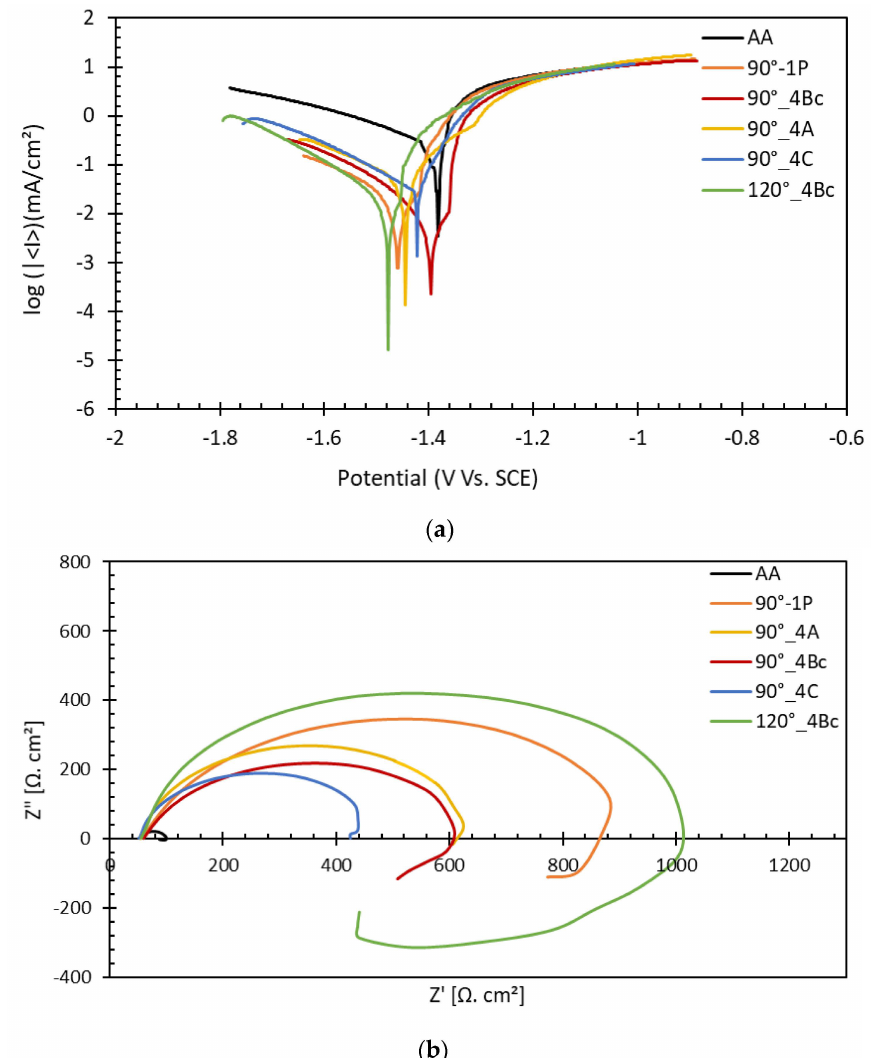
Figure 5. Corrosion measurements ( a ) potentiodynamic polarization curves, and ( b ) Nyquist plot of AA and ECAPed billets processed via various ECAP